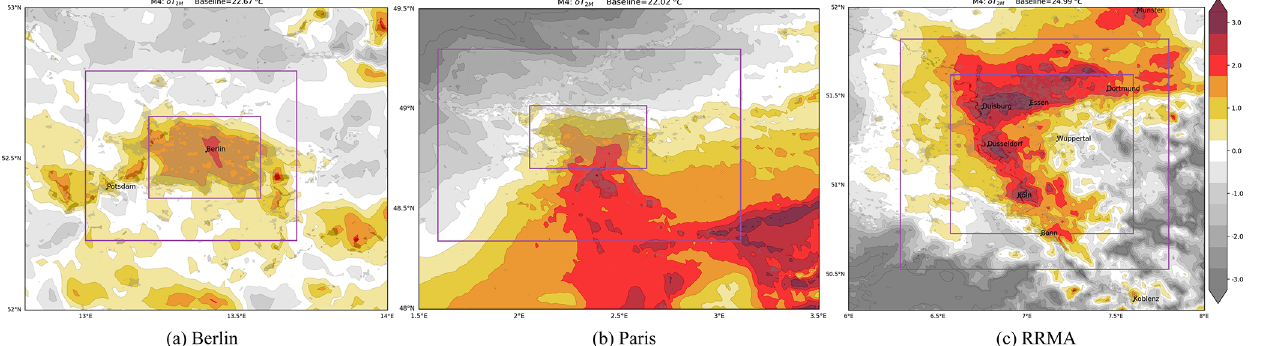
Figure A1. UHI calculated with M4 on the original grid (no interpolation) for Berlin, Paris and the Rhine-Ruhr Metropolitan Area (a–c) , the rural area used as baseline is encompassed by the two purple rectangles, or in Fig. 1 as the sum of purple and orange grid-points.